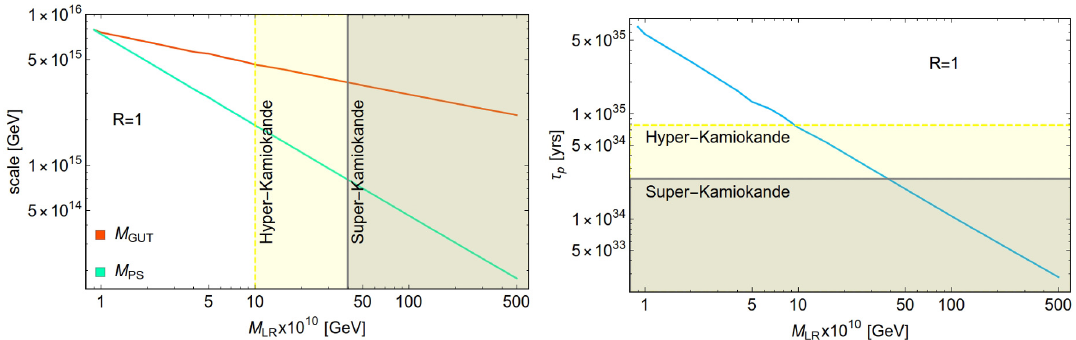
Figure 9 . Plot without incorporating threshold correction, i.e., R = 1 . Current Super-K bound requires M II < 4 × 10 11 GeV, and future Hyper-K bound would push this scale to below M II < 10 11 GeV.